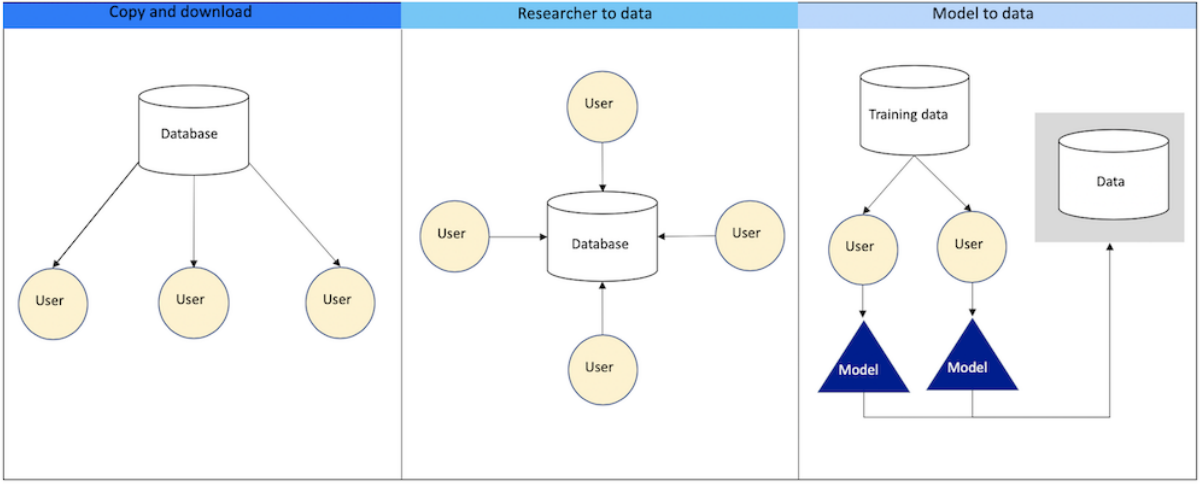
Figure 1. Common Data Sharing